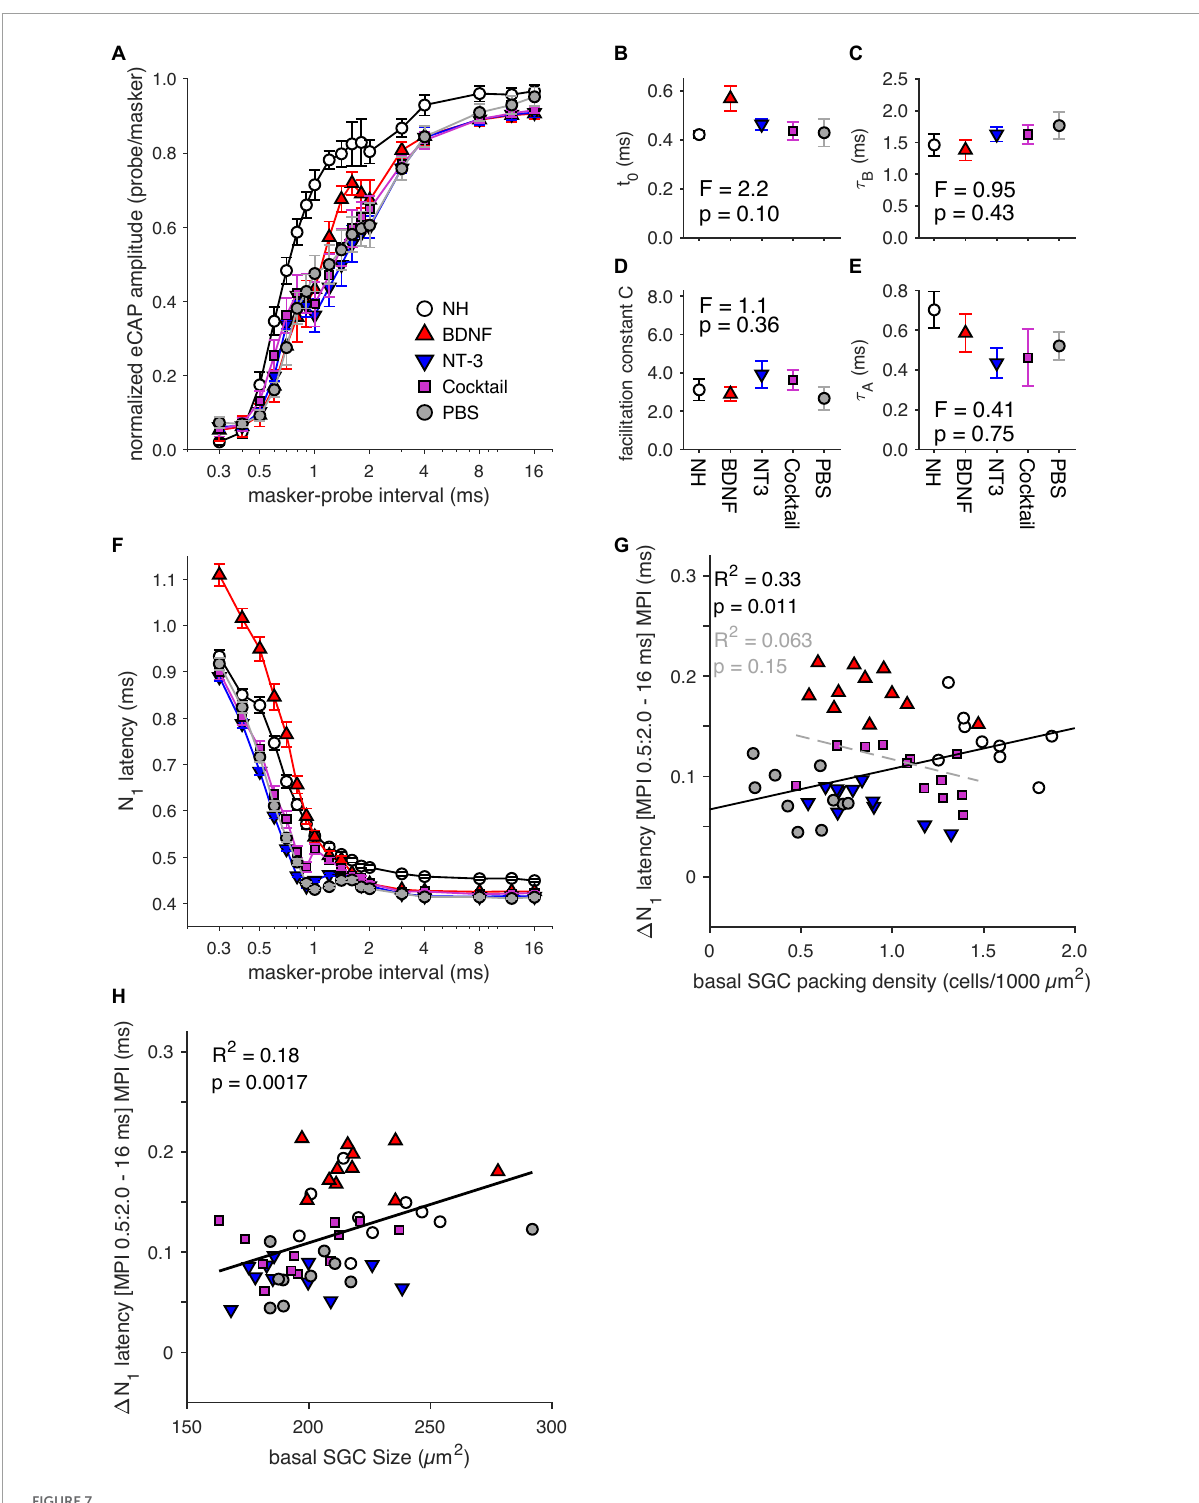
FIGURE7 (A) Group means of masker-probe recovery functions constructed using 18 masker-probe intervals (MPIs; range: 0.3–16 ms). (B–E) Fitting parameters derived from fitting a double exponential to the recovery functions in panel (A) . (F) N 1 latency of the eCAP evoked by the probe stimulus for the 18 MPIs. (G) (cid:49) N 1 latency between the mean latency of the MPI range 0.5–2 ms, and that for the 16-ms MPI for individual animals as a function of basal SGC packing density. (H) (cid:49) N 1 latency between the mean latency of the MPI range 0.5–2 ms, and that for the 16-ms MPI for individual animals as a function of basal SGC size. NH, n = 9; PBS, n = 10; BDNF, n = 11; NT-3, n = 11; Cocktail, n = 12. Error bars represent